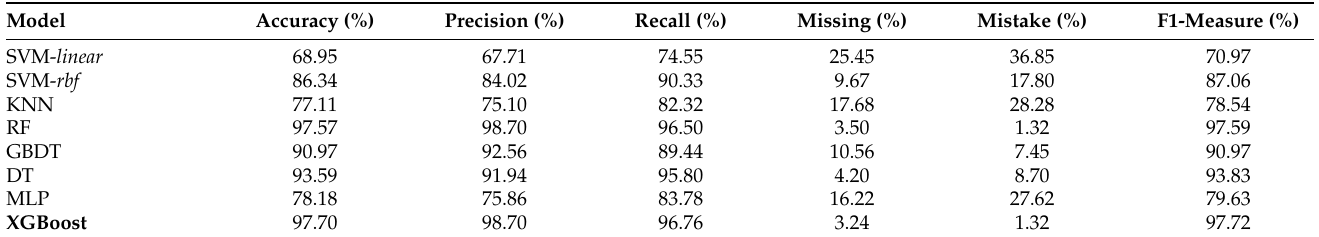
Table 6. Experimental results of various ML models with optimal